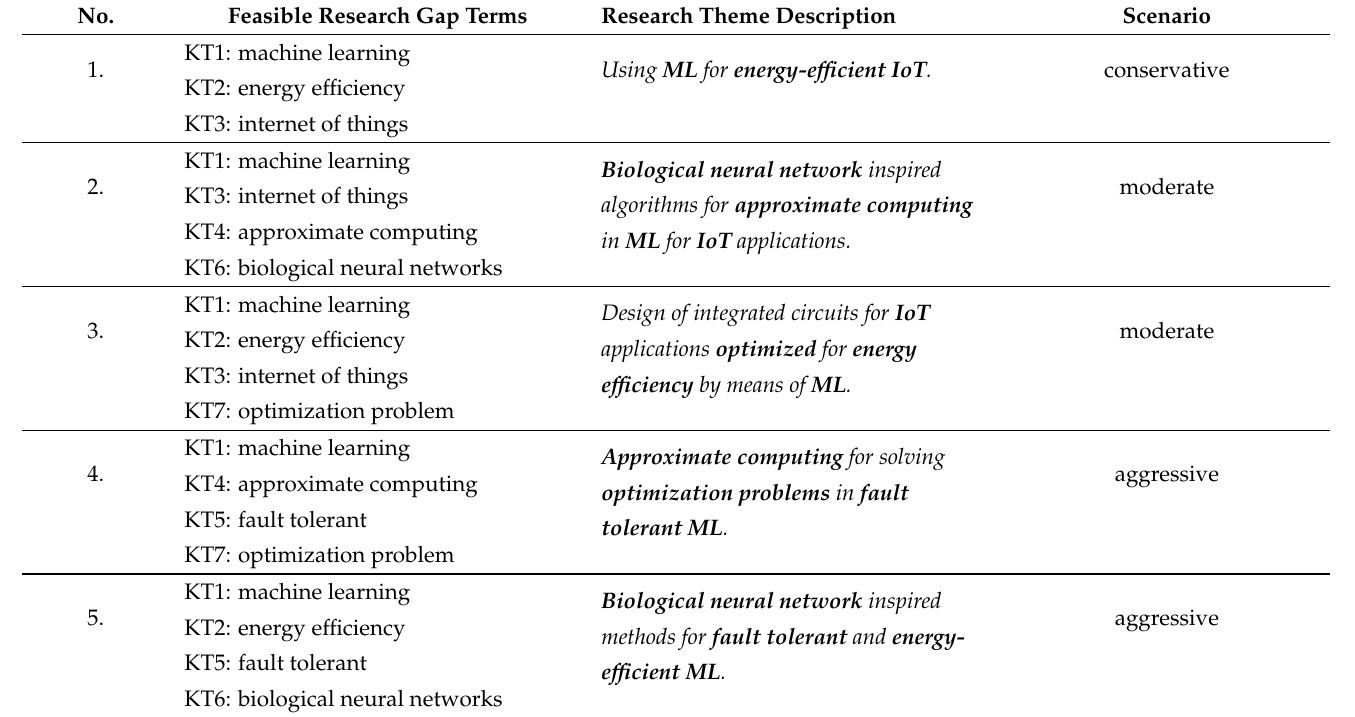
Table 3. Research topic examples considering research